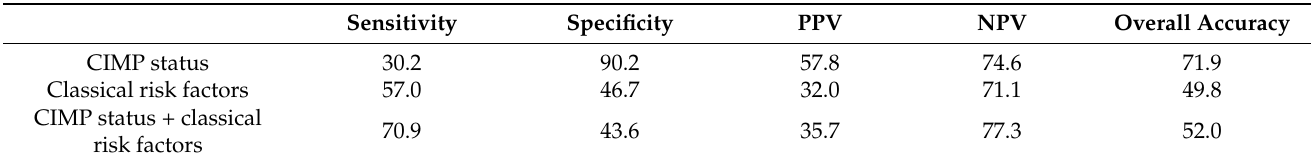
Table 5. Performance characteristics of CIMP status, classical risk factors, or both combined for estimation of MACL risk after colonic polyp